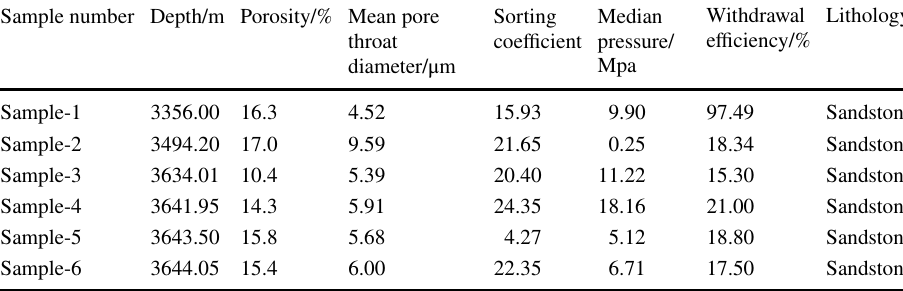
Fig. 11 Cement content and physical properties of different sand bod- ies in the Dawangzhuang area of the Raoyang sag Table 4 Capillary pressure